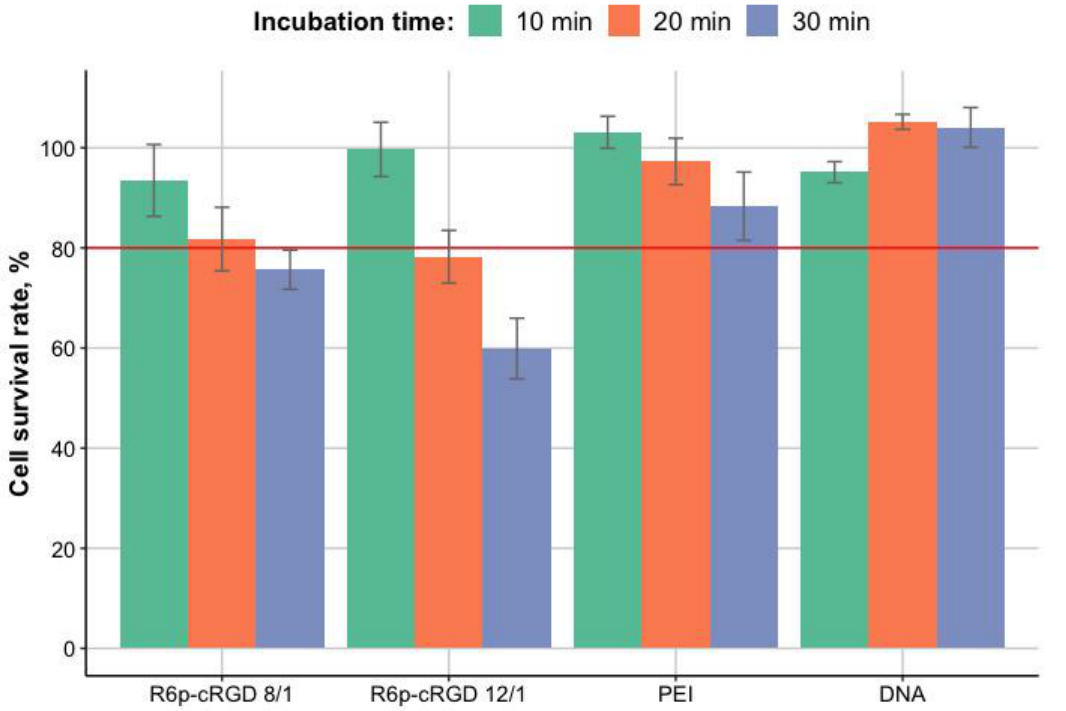
Figure 5. Survival rate of PANC-1 cells (%) after transfection with R6p-cRGD/DNA/MNPs poly- plexes. DNA:MNP quantity ratio is 1:0.05. The threshold indicates the acceptable level of cell survival (80%).